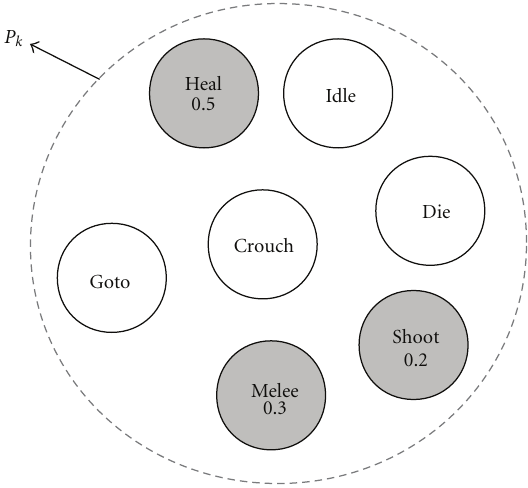
Figure 1: An example of Tactical Agent Personality (TAP). Each action is tagged with a relative action value that can be evaluated into a probability of choosing it. The shaded ones are the adaptable actions whilst the unshaded ones are